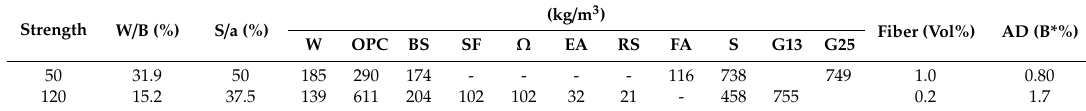
Table 1. Mix proportions of 50 and 120 MPa concrete.